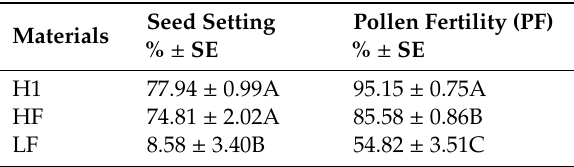
Table 1. Seed setting and pollen fertility of Huaduo1 (H1), HF, and LF.